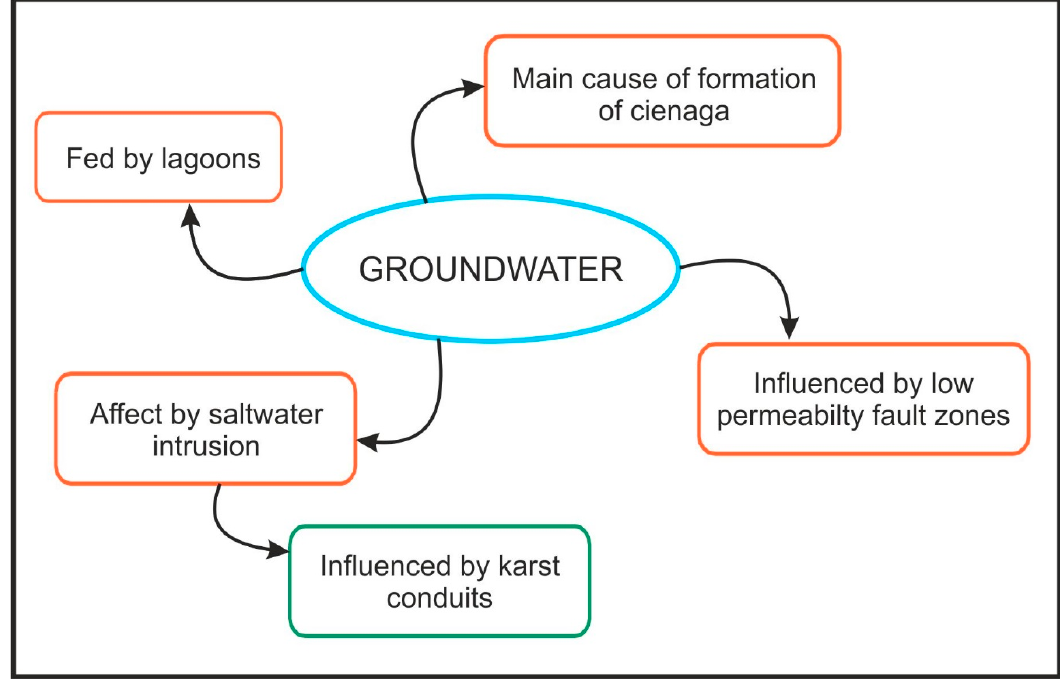
Figure 13. Conceptual diagram showing the main factors influencing the groundwater flow system.